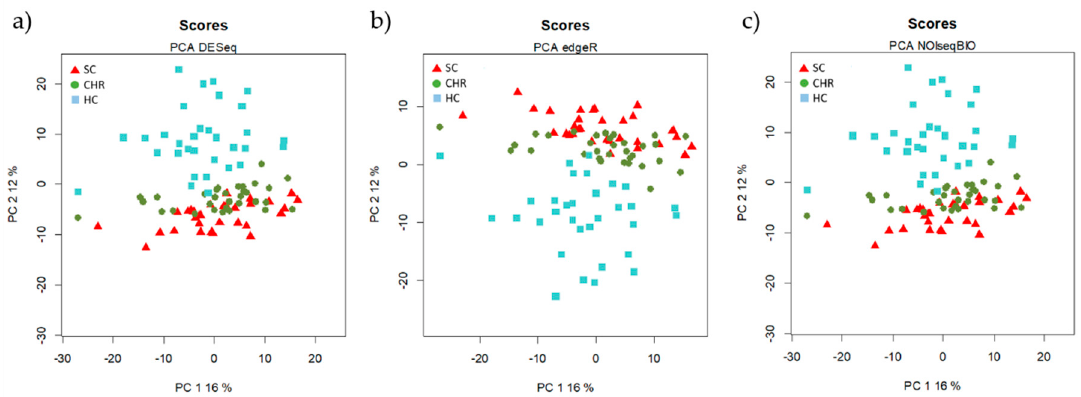
Figure 1. Unsupervised Principal Component Analysis (PCA) of the data normalized by the three methods of normalization ( a ) DESeq, ( b ) edgeR, and ( c ) NOIseq. Each symbol represents the miRNA profile from one of the 96 participants of the study. All methods show an overlap between HCV chronic naïve (CHC) patients and spontaneously clarified HCV (SC) individuals.